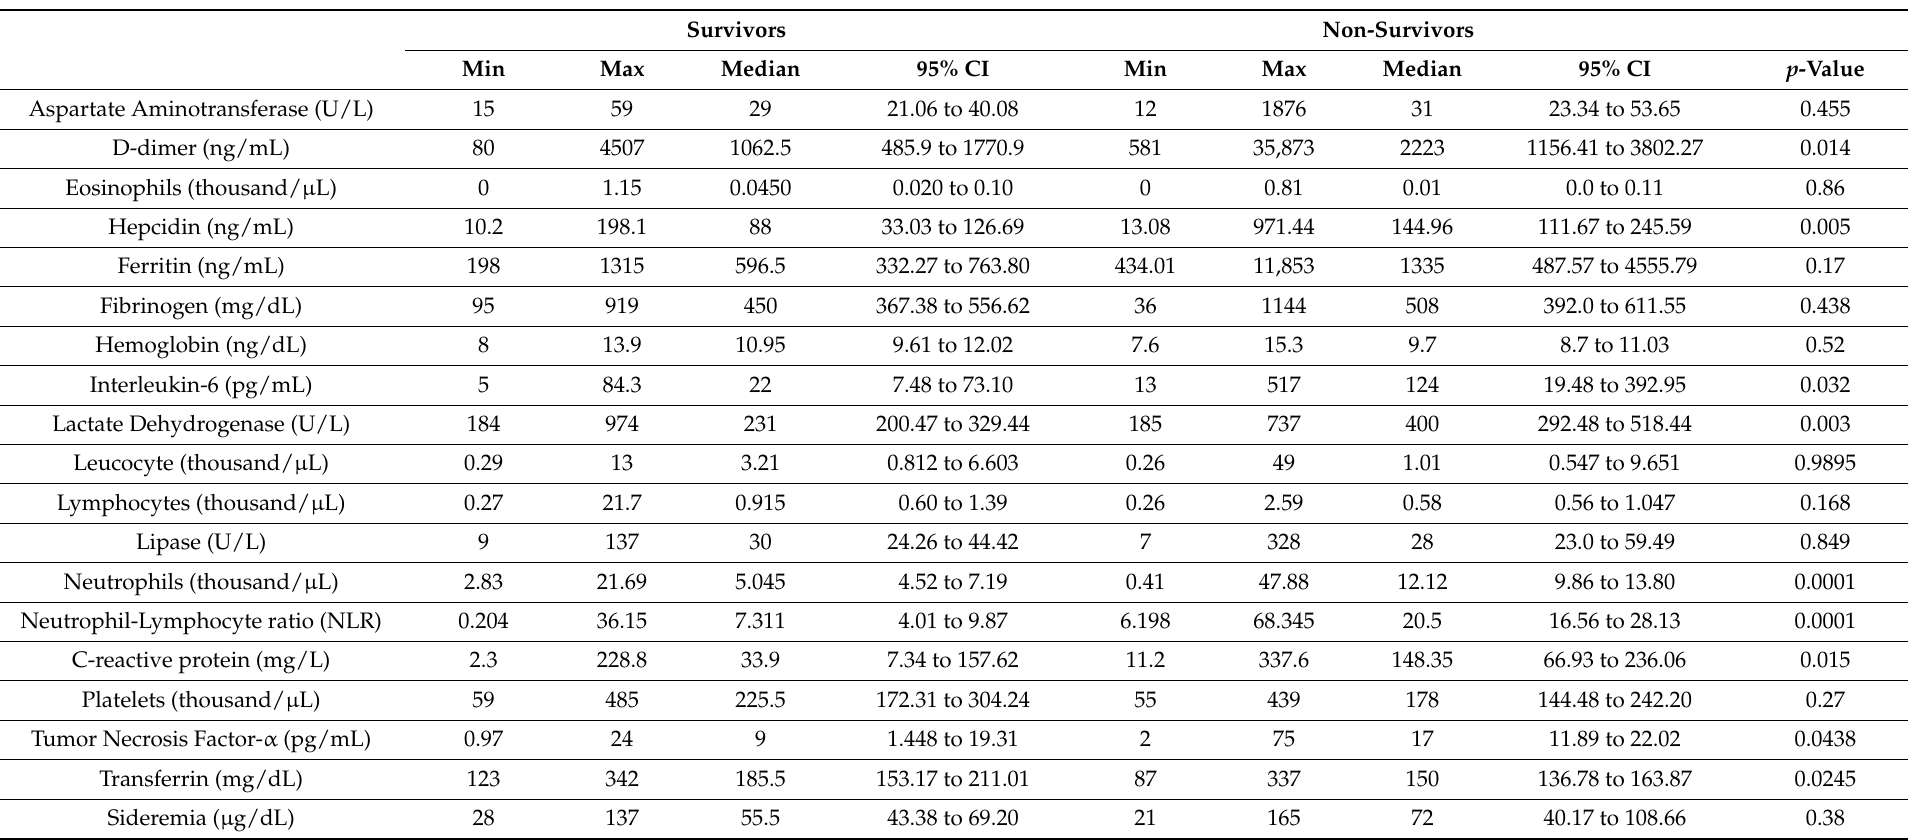
Table 1. Statistical analysis of laboratory parameters. For each study group are indicated: minimum, maximum, median and 95% confidence interval. A p -value higher than 0.05 (>0.05) is not statistically